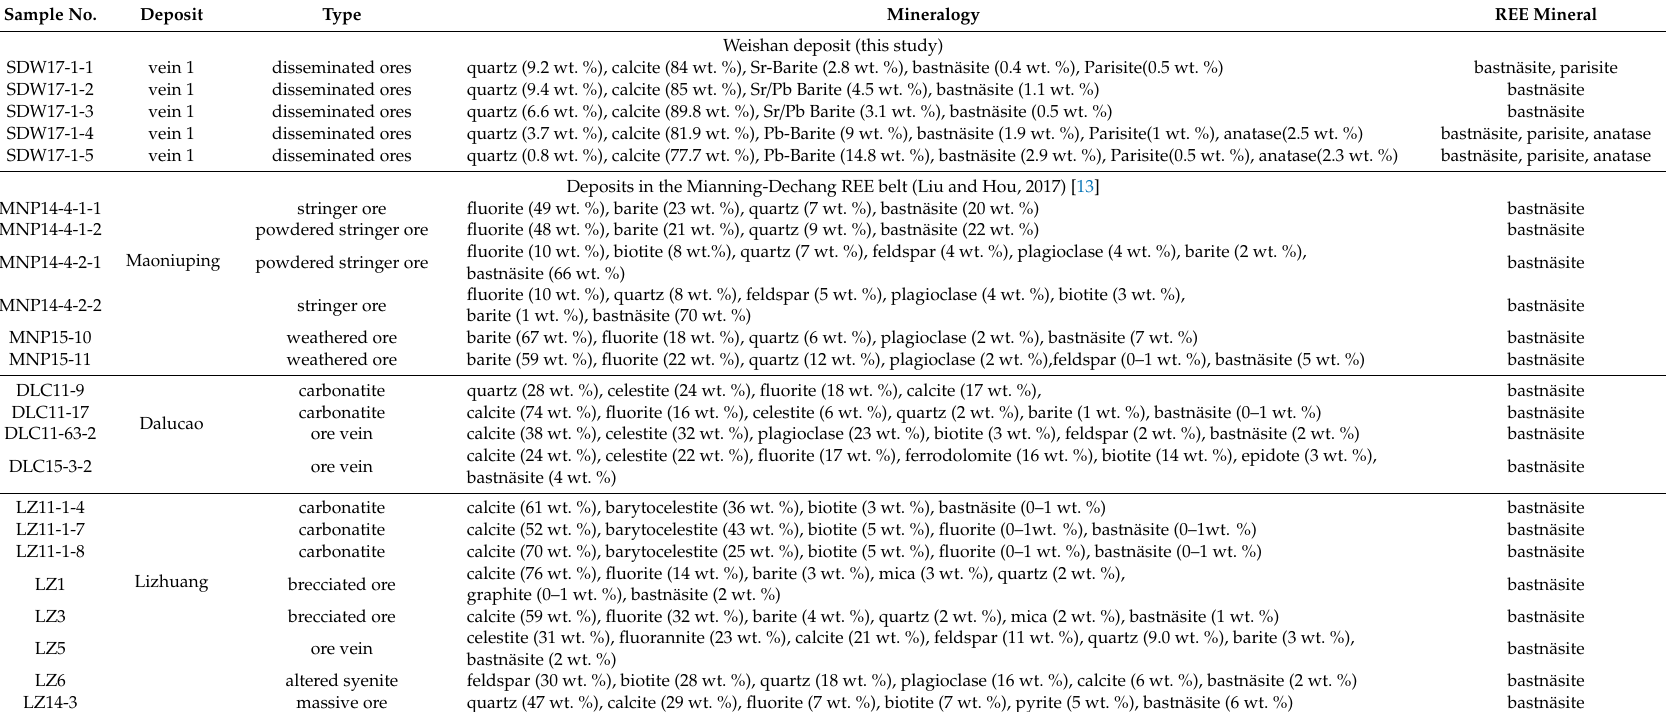
Table 3. Mineralogy of typical samples from the Weishan, Maoniuping, Dalucao, and Lizhuang REE deposits determined by XRD analyses. Sample